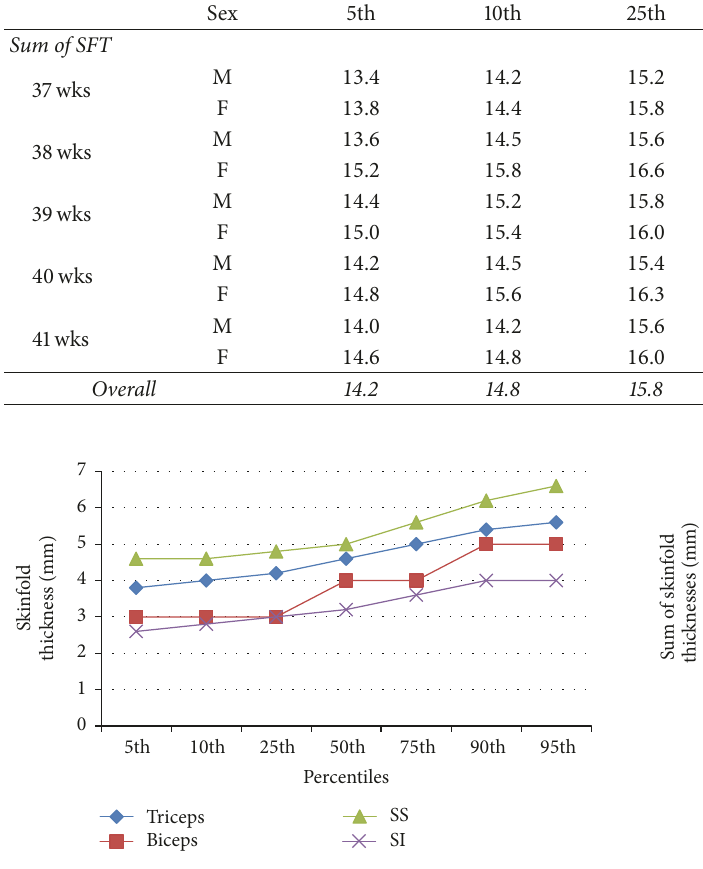
Figure 1: Percentile values for skinfold thickness at various sites in all males.